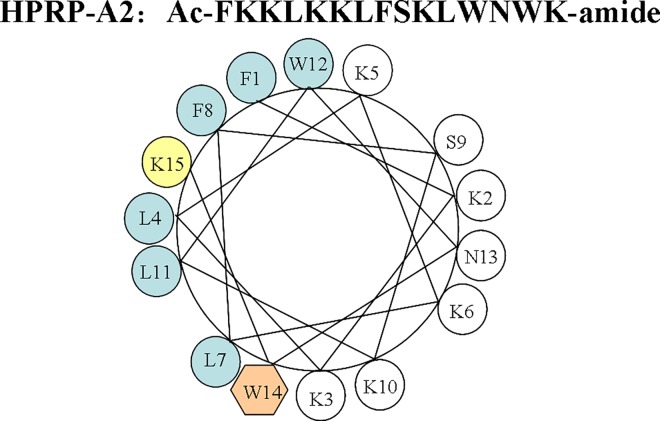
Peptide sequence and the helical wheel of HPRP-A2.